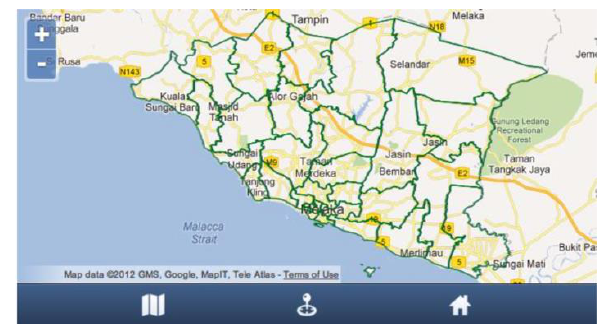
Figure 5. The Dun Melaka Using new Algorithm and Formula